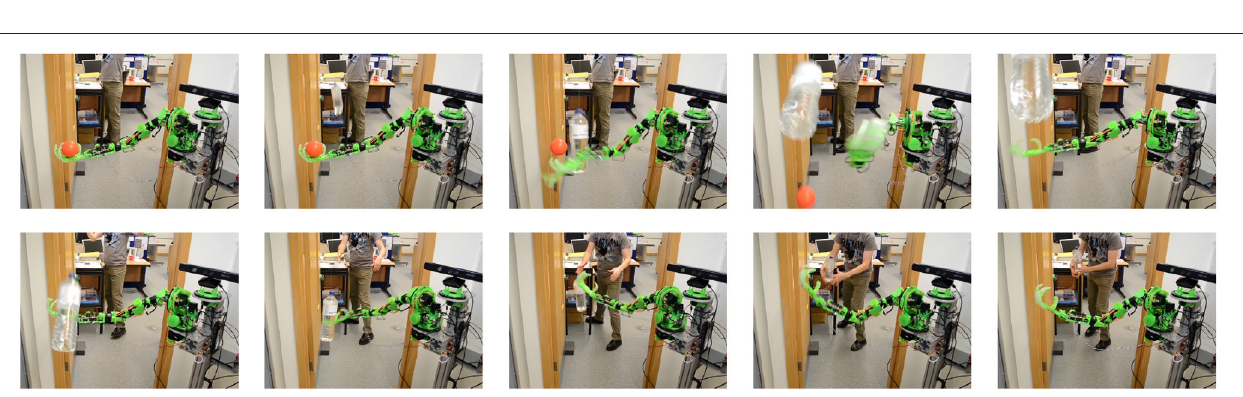
FIGURE 11 | In (A) is seen the commanded co-contraction (c), and in (B) the actual actuator positions ( α flexor and α extensor ), for the two-phase ballistic/feedback controller with extended arm and a 275 g mass payload. See Figure 10B for the corresponding desired and actual joint output positions (joint angles).